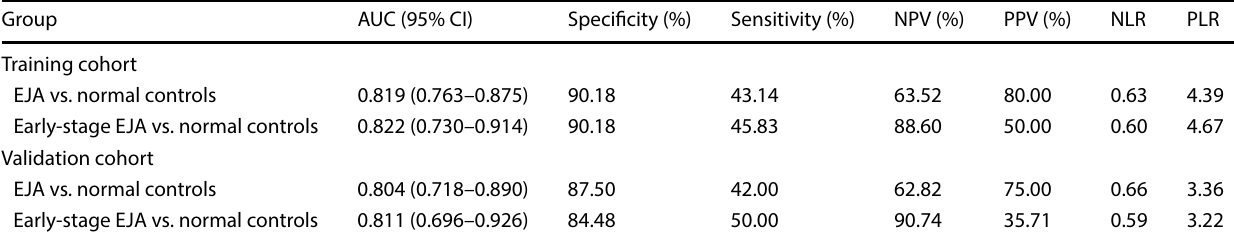
Fig. 2 Level and ROC curve analysis of serum IGFBP3 for EJA. Serum IGFBP3 levels in normal controls, EJA and early-stage EJA patients in training cohort ( A ) and valida- tion cohort ( B ) are shown in scatter plot and box plot. The lines in the box are means. The ROC curves of serum IGFBP3 to distinguish EJA and early-stage EJA patients and normal controls in training cohort ( C ) and validation cohort ( D ). The “EJA” curve (blue line) shows healthy subjects vs. all EJA subjects (early + late-stage), and the “early-stage EJA” curve (green line) shows healthy subjects vs. only the early-stage EJA subjects. EJA esophagogastric